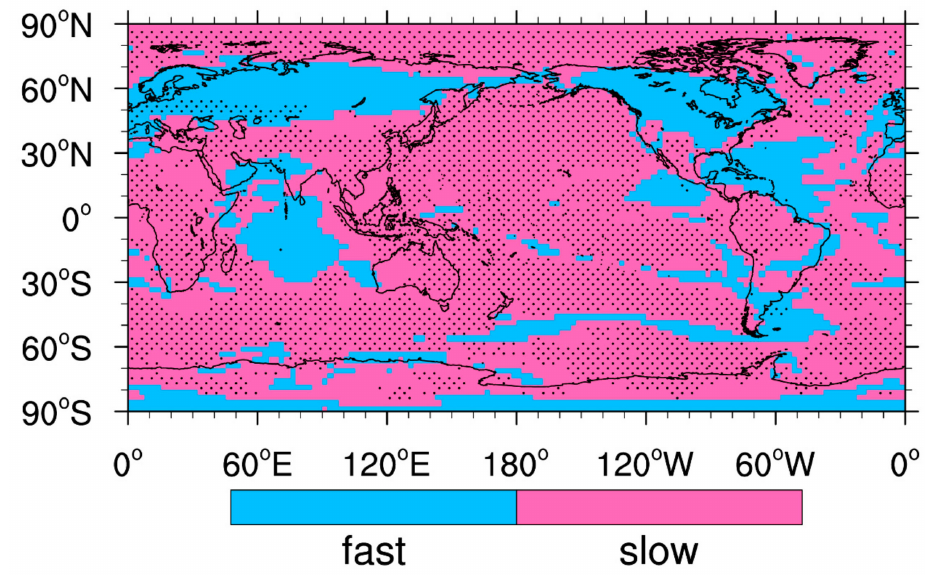
Figure 5. Regions with TCC changes dominated by the fast (blue) and slow response (pink), respec- tively. Black dot represents that at least 8 models agree with the sign of